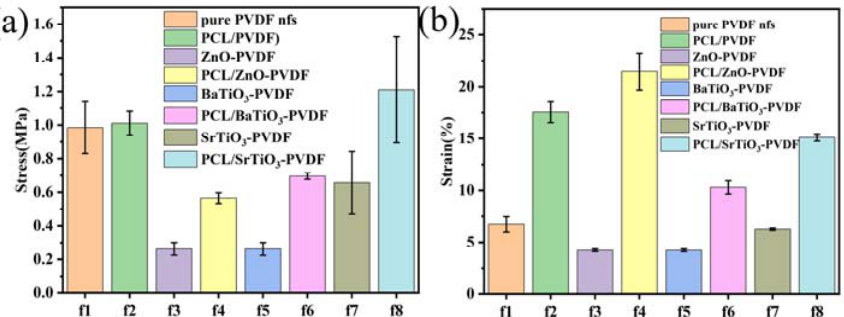
Figure 4. Mechanical properties of fibers. ( a ) Tensile strength of seven kinds of electrospun sheets. ( b ) Elongation failure of fi bers.